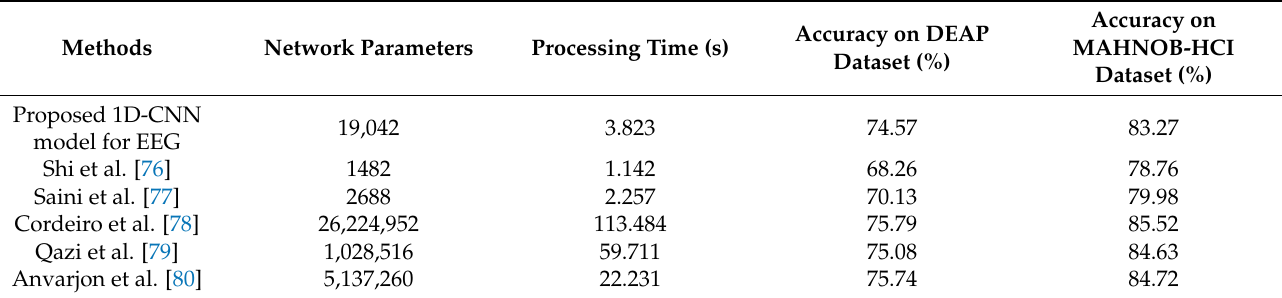
Table 12. Comparison of performance between proposed 1D-CNN model for EEG signals and other lightweight